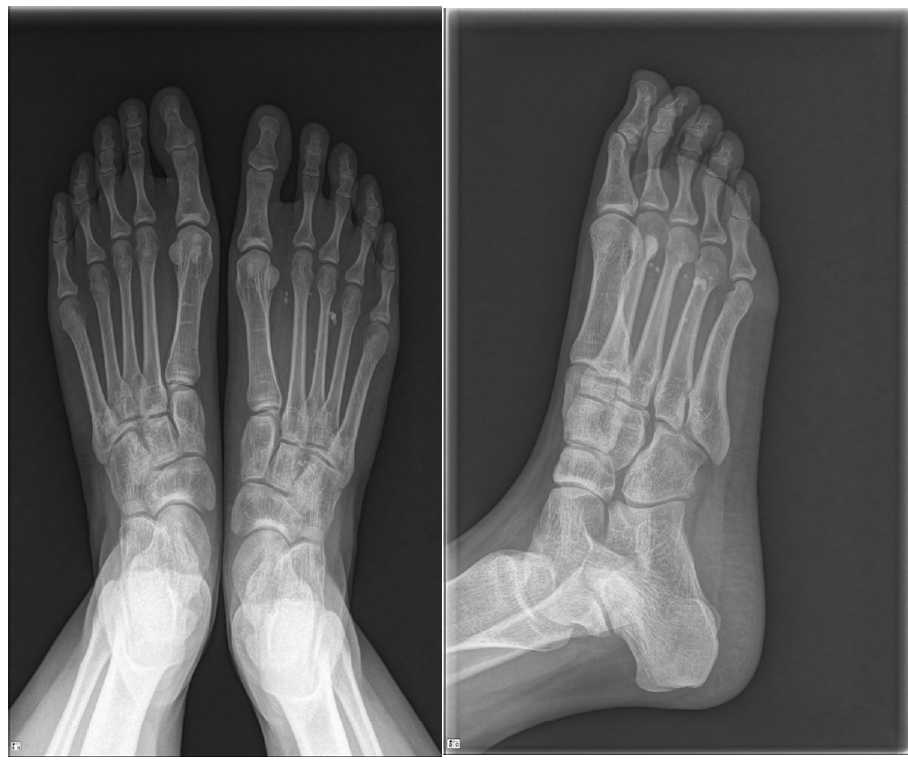
Figure 1. Plain radiographs of the right foot showing phleboliths scattered throughout the first to third intermetatarsal spaces.